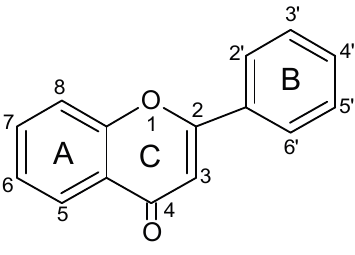
Figure 3. The basic structure of